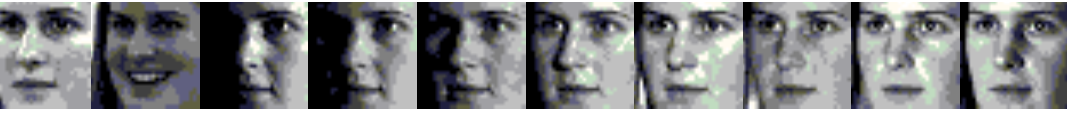
Table 4. Computation time on CMU PIE face database under different trains for one run (time in